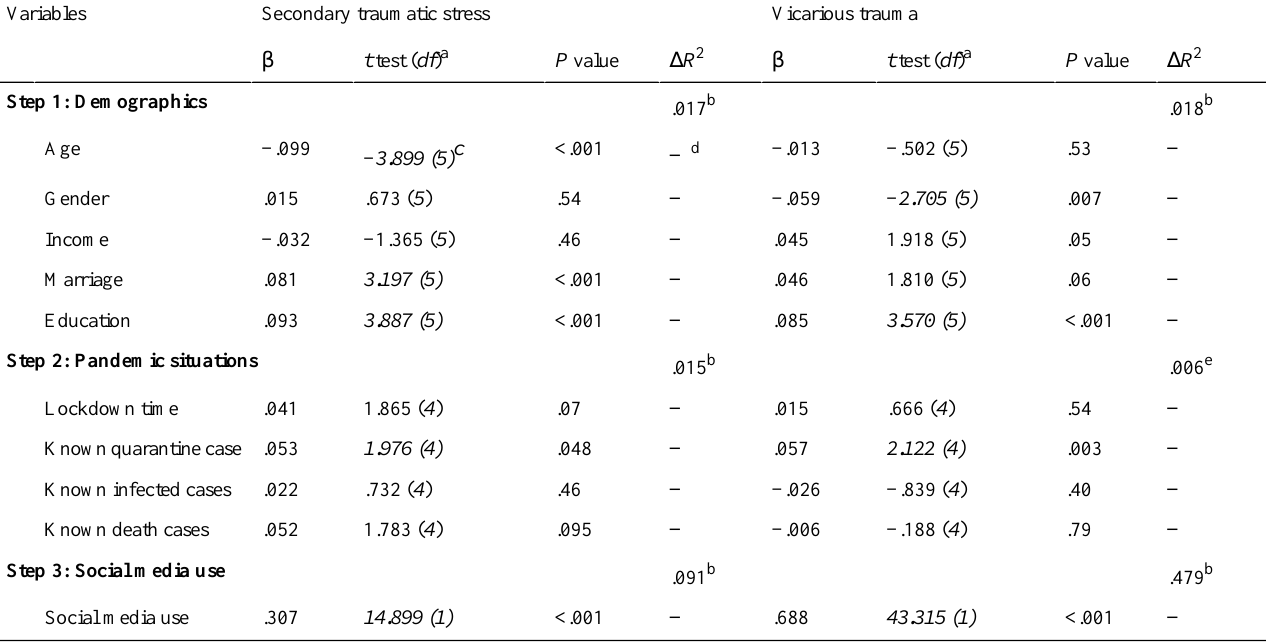
Table 3. Factors contributing to secondary traumatic stress and vicarious trauma.